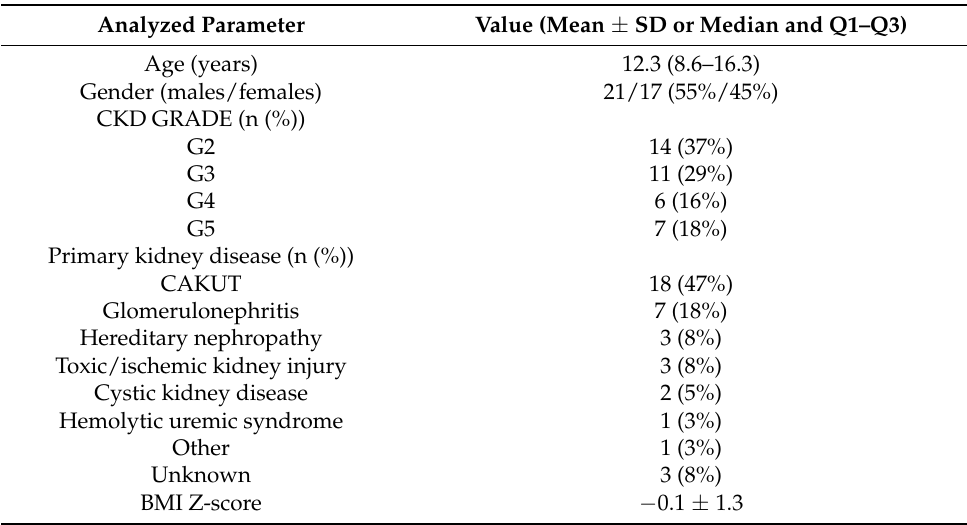
Table 1. Clinical and biochemical data of the studied children. Analyzed